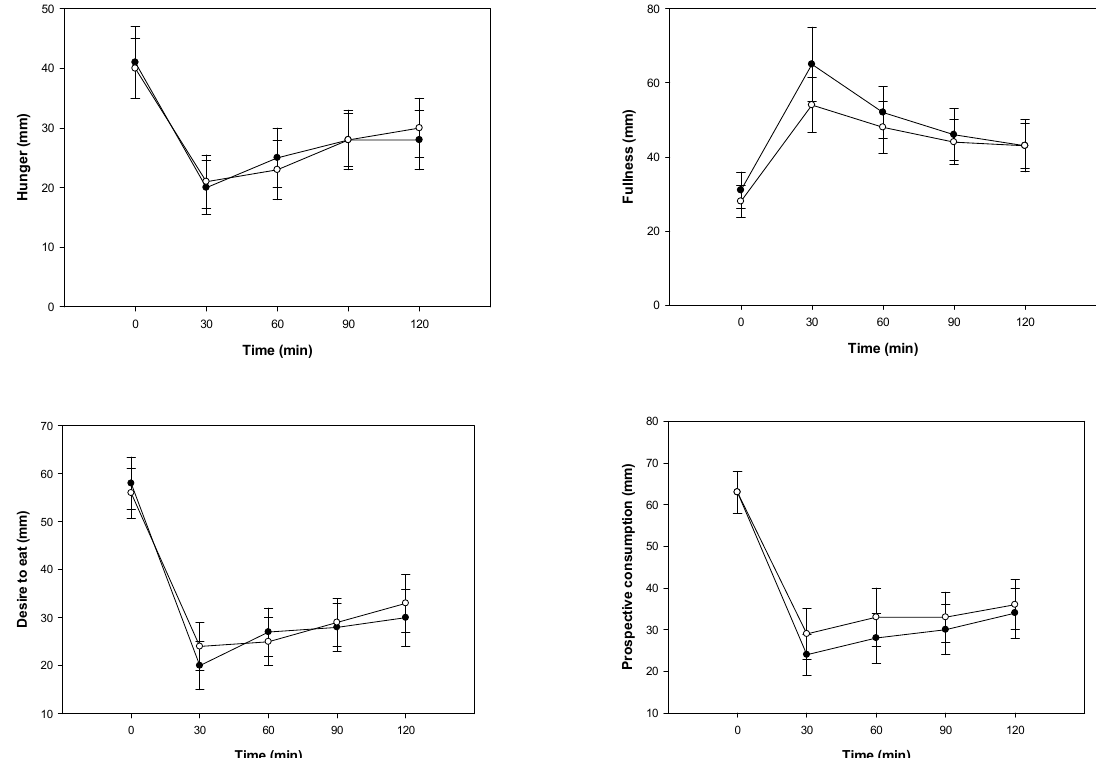
Figure 4. Perceived appetite response after the consumption of blueberries ( ● ) or placebo gel ( ○ ) breakfast meals. Data are presented as arithmetic means ± SE, n = 17. All times points were significantly different from baseline, p < 0.05. For hunger, fullness, desire to eat and prospective consumption, there were no significant differences between responses from the blueberry or placebo breakfast meals.